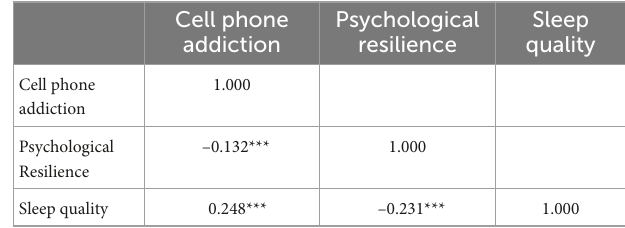
TABLE 4 Correlation analysis of cell phone addiction, sleep disorder, and psychological resilience among college students ( n =